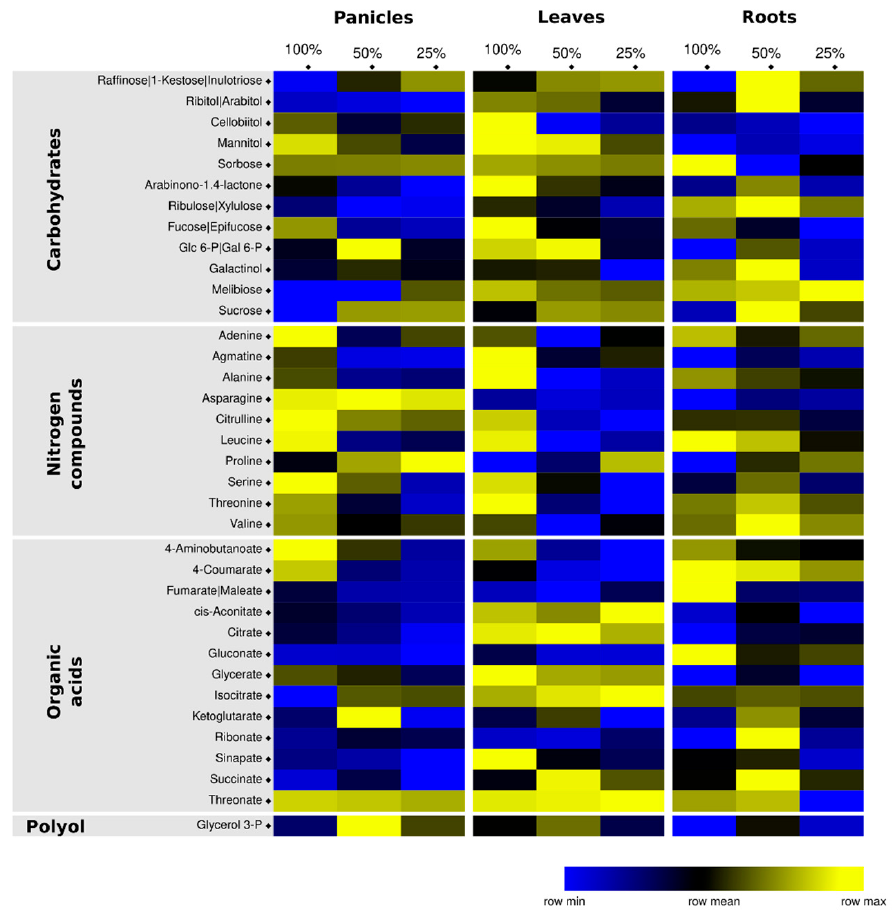
Figure 2. Content of PC1 and PC2 metabolites (36) in the panicles, leaves and roots of S. viridis plants submitted to three different water treatments: 100% (control), 50% and 25% of soil pot capacity (SPC). The relative concentration of each metabolite is the average of five biological replicates, including NA samples (no detectable values). Corresponding standard deviation values are shown in Supplemental Table S1.